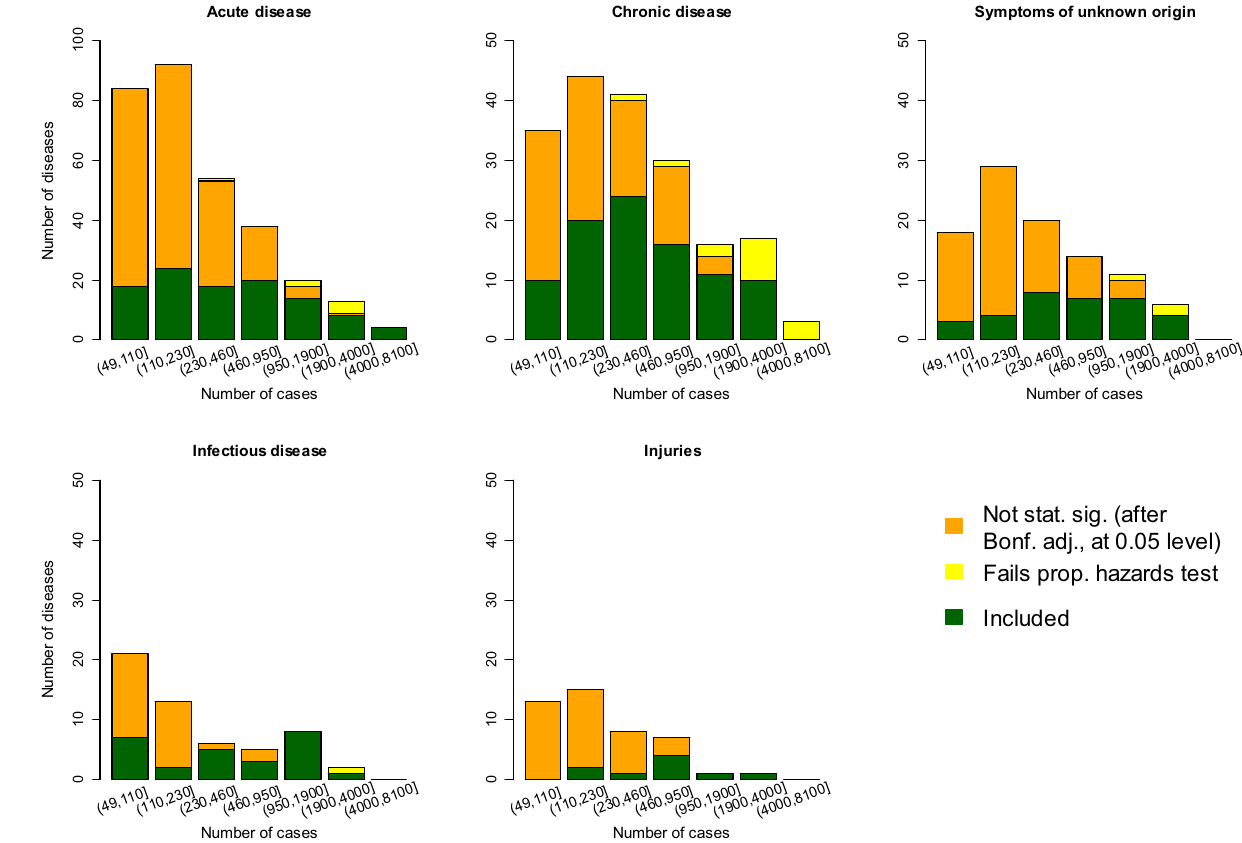
Figure 2. 689 diseases of men or women were categorised as acute, chronic, infectious, injuries, or symptoms of unknown cause (separate plots), and grouped by the number of cases (horizontal axes). We considered: whether associations were statistically significant at the 0.05 level after a Bonferroni multiple-testing adjustment?—no (orange), or if yes, whether proportional hazards test did (green) or did not (yellow) pass. The median number of cases was 214. The vertical axis for acute diseases has a different